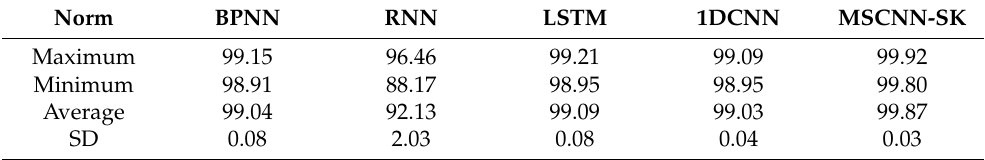
Table 5. Four-opamp double second-order high-pass filter circuit fault diagnosis comparative experiment. Norm